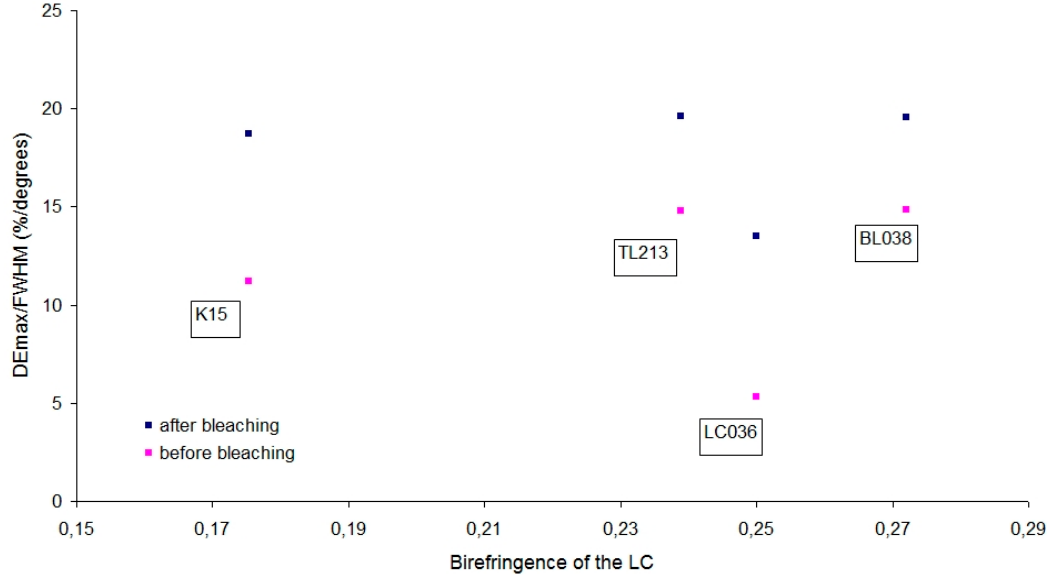
Figure 8. DEmax divided by the FWHM versus the birefringence of the corresponding LC of each graph in Figure 7.